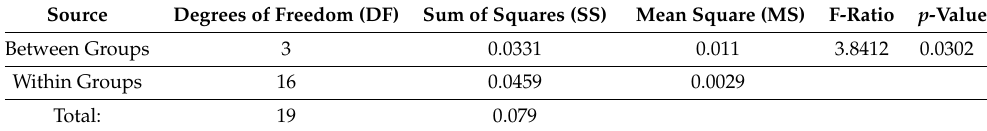
Table 6. ANOVA source table for the F 1 score of the drone experiment.